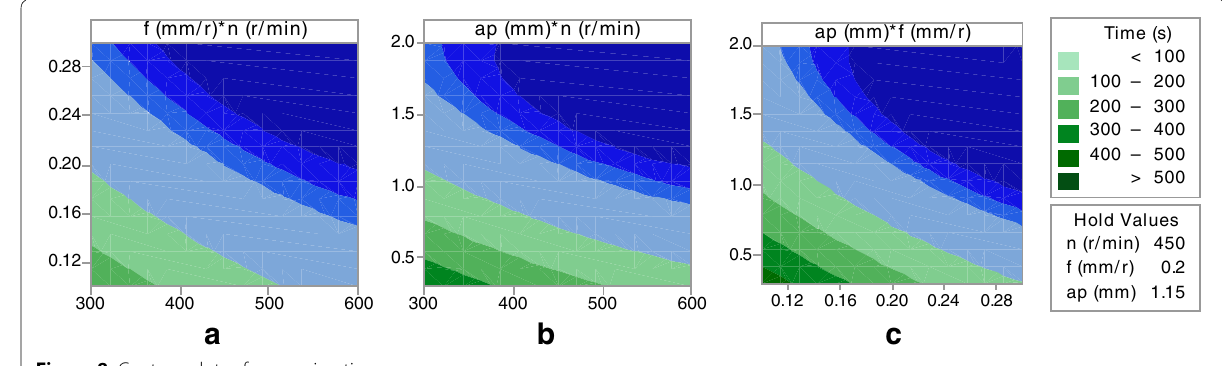
Figure 8 Contour plots of processing time